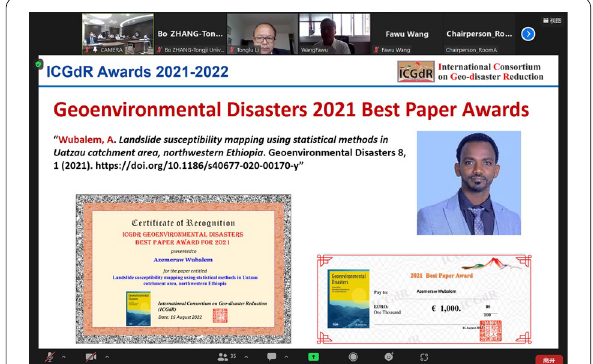
Fig. 3 2021 Best Paper Award of the ICGdR official journal: Geoenvironmental disasters